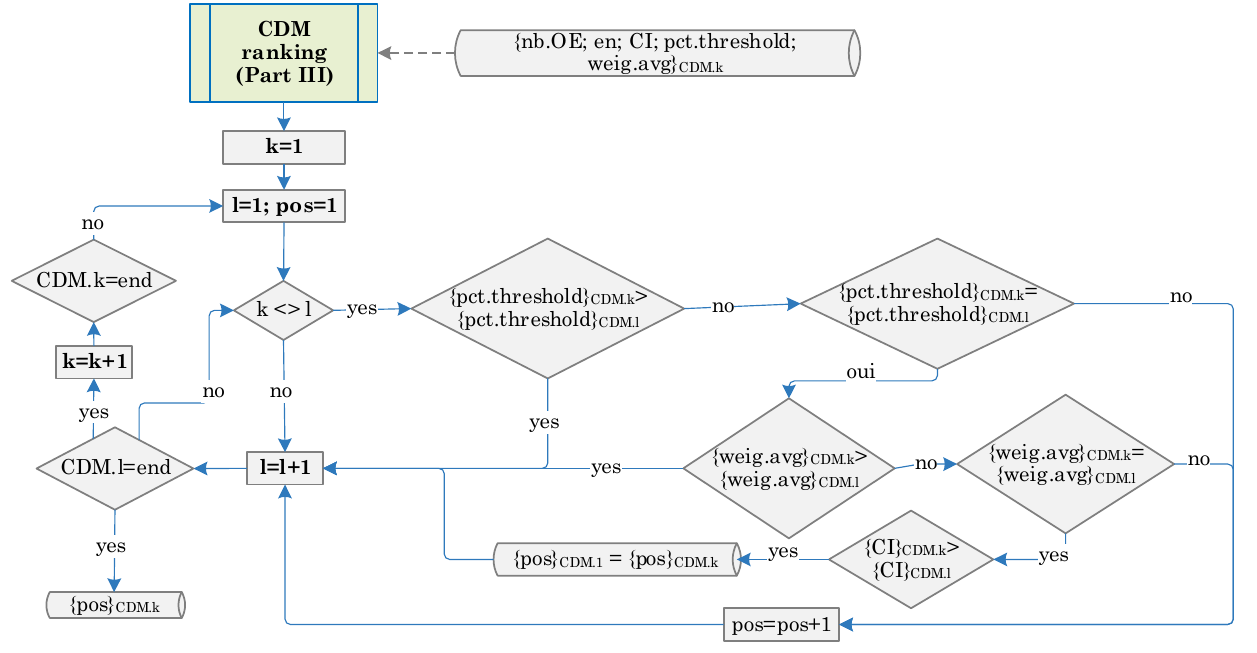
Figure 5. Ranking procedure.